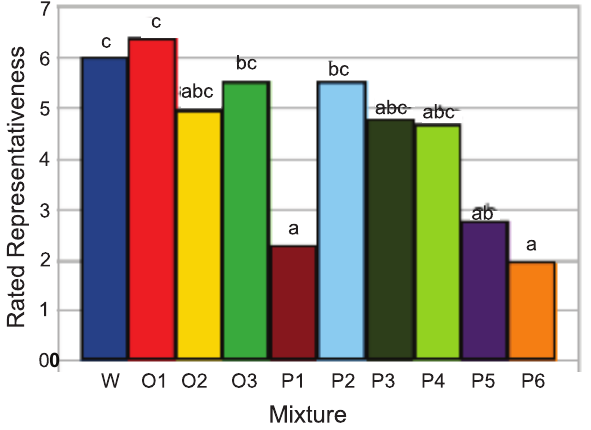
Figure 5. The rated representativeness of the aroma of samples W, O1–O3, and P1–P6 as compared by panelists to the aroma of whole flowering lavender. Letters a, b, c refer to the mixture’s Significant Difference from each other- if two samples do not share a letter, they are significantly different. Samples P1, P5, and P6 are significantly less representative of the aroma of flowering lavender than sample W, which incorporates all the volatiles in flowering lavender.